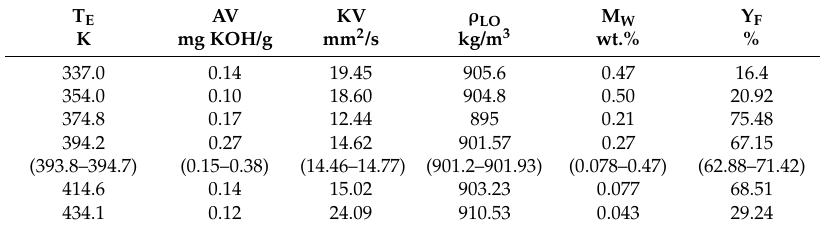
Table 2. Effects of esterification temperature T E on the performance of esterification of JO by continuous addition of IPA/H under conditions of m O = 200 g, M IOE = 5, M H/HO = 0.94 wt.%, Q IPA/H = 1.5 mL/min, and t E = 58.5 min. P UI = 420 W.